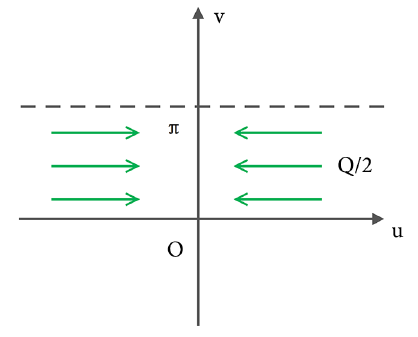
Figure 6. Parallel flow diagram of